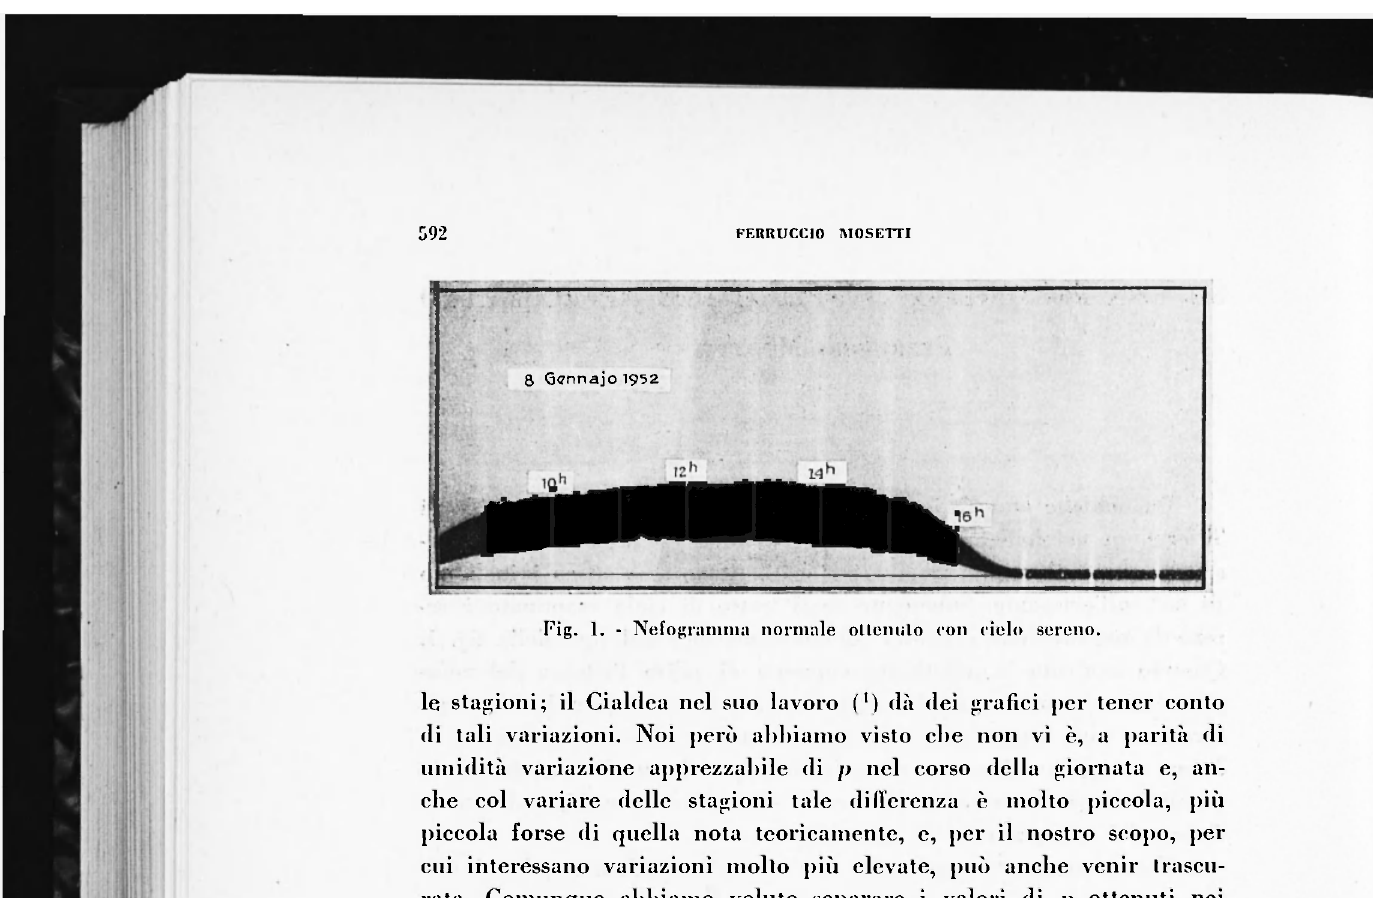
Fig. 1. - Nefogramma normale ottenuto con cielo